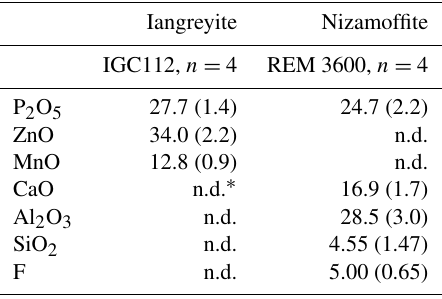
Table 5. EDS analyses with standard deviations in